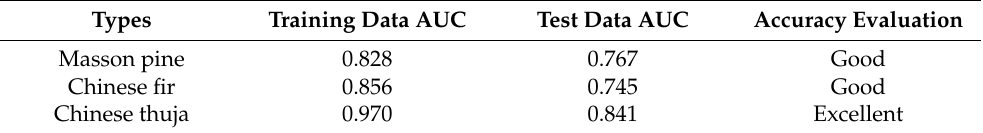
Table 4. Evaluation table of simulation accuracy of main coniferous species in Hubei Province.